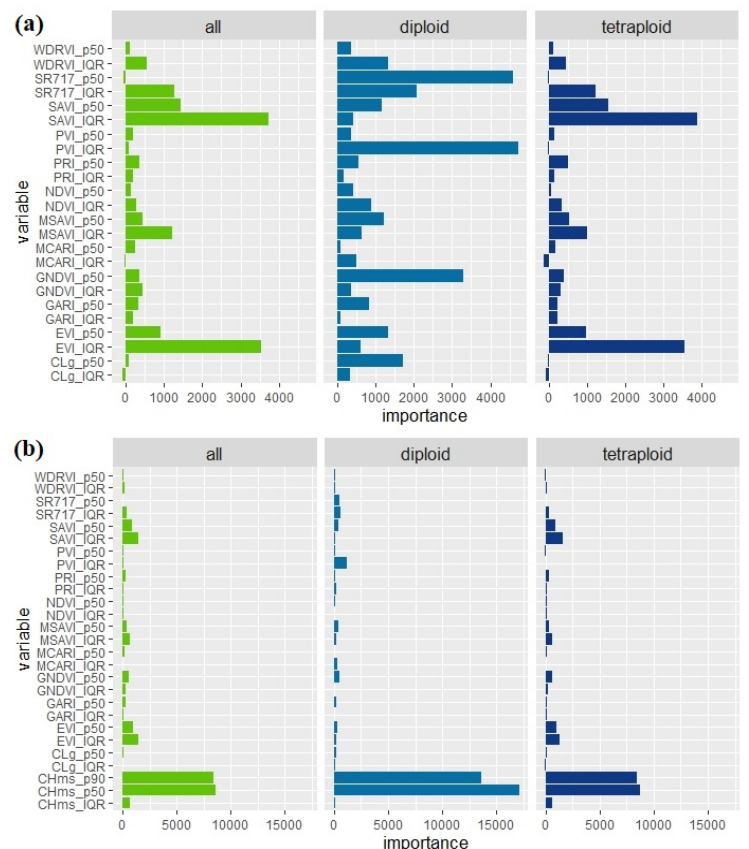
Figure 9. Random forest variable importance plot showing predictor variables based on MS sensor: ( a ) VIs ( b ) VIs combined with CH information relevant in predicting dry matter yield of perennial ryegrass for all, diploid, and tetraploid tested plots.